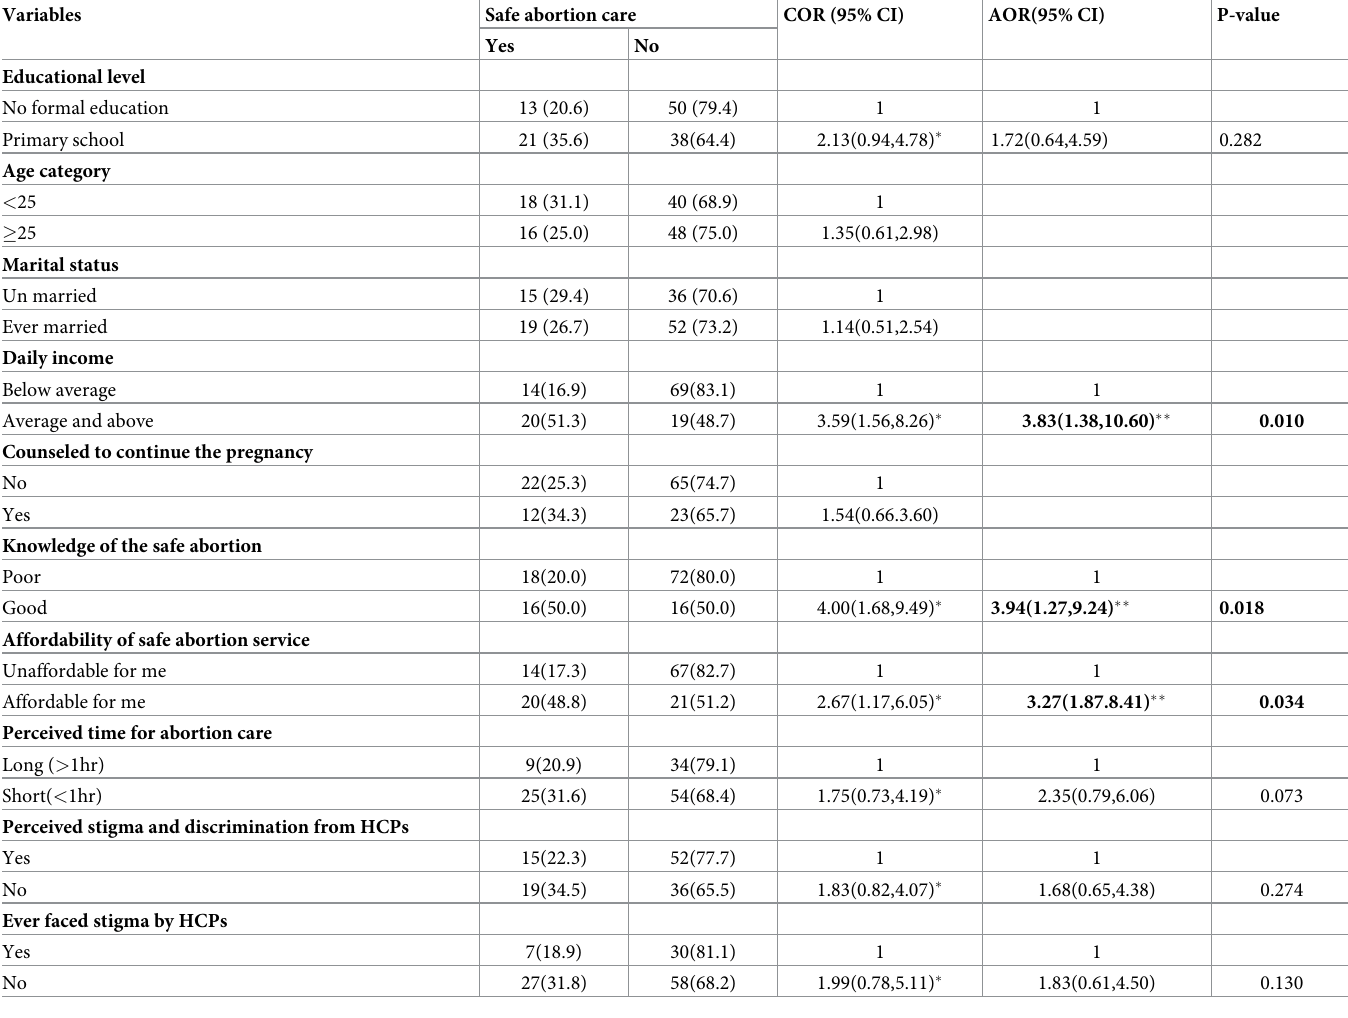
Table 3. Factors associated with safe abortion service utilization among insecurely housed women in southwest Ethiopia,